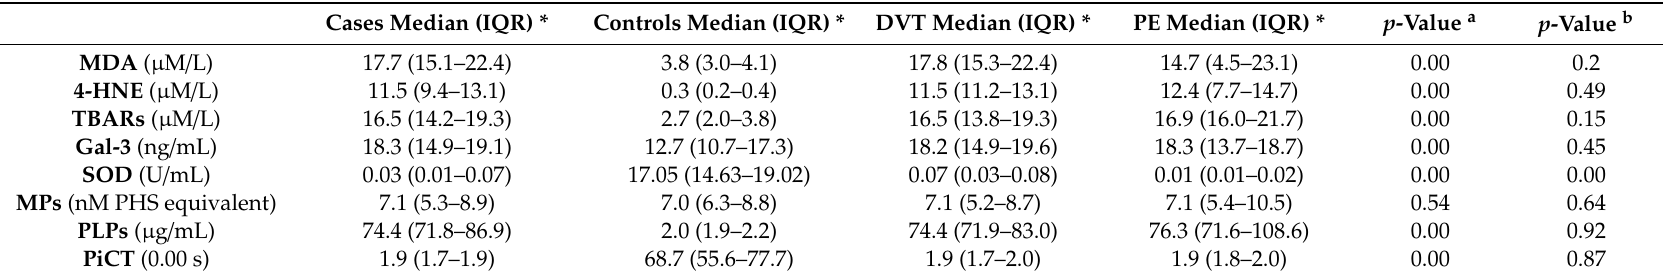
Table 2. The median values of di ff erent measured biomarkers in overalls case and in controls, as well as in patients having deep vein thrombosis (DVT) and pulmonary embolism (PE). We performed statistical comparison (Mann–Whitney U test) concerning the overall cases vs. controls and DVT vs.